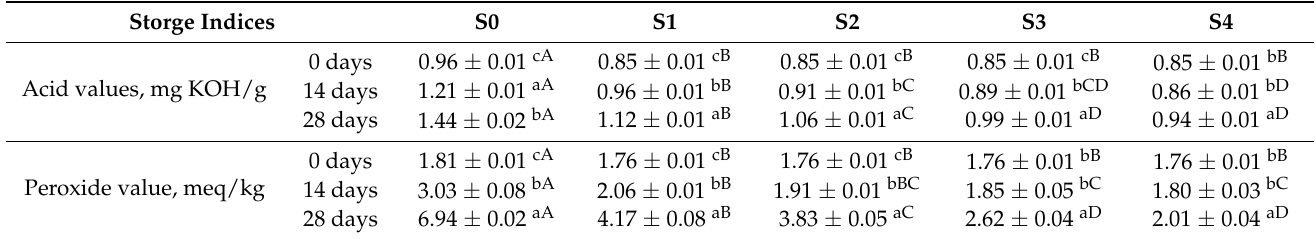
Table 6. The oxidative stability of the mayonnaise.